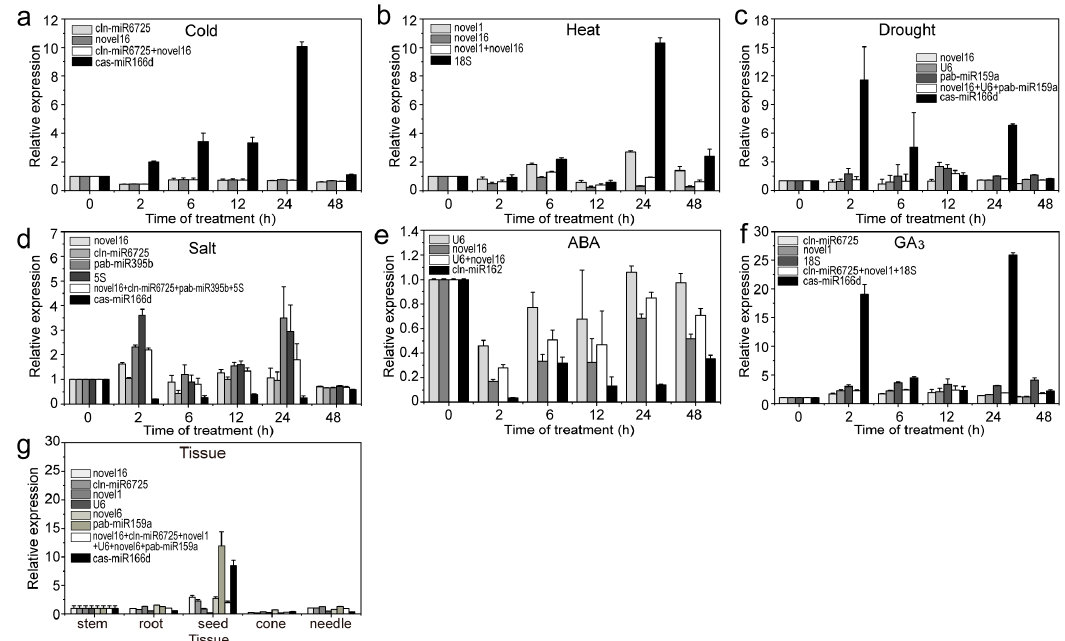
Figure 8. Relative expression levels of aly-miR164c-5p under different experimental conditions. Results for ( a ) 4 °C cold stress; ( b ) 40 °C heat stress; ( c ) drought stress simulated by 15% PEG-6000 treatment; ( d ) salt stress stimulated by 200 mM NaCl treatment; ( e ) 200 μ M ABA treatment; ( f ) 200 μ M GA 3 treatment; ( g ) different tissues (roots, stems, tender needles, cones and seeds). Error bars represent standard deviations (SD) (n = 3).